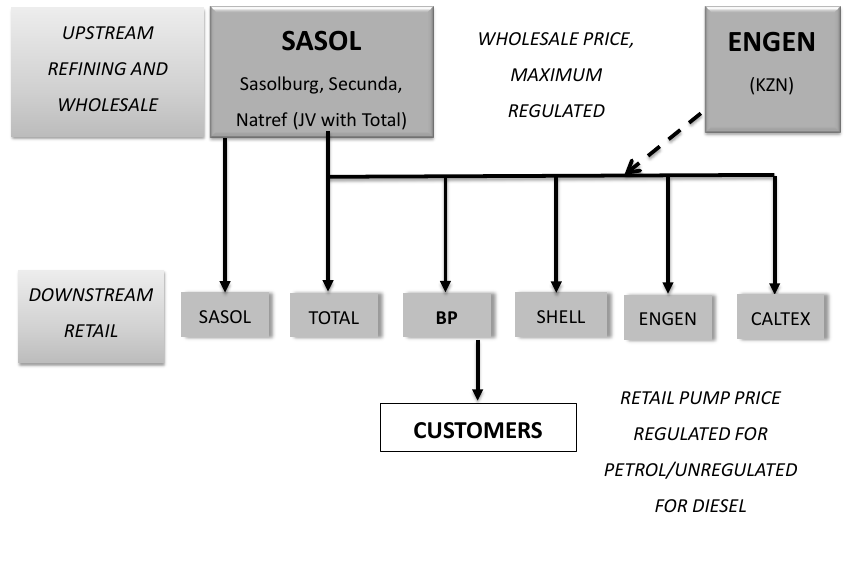
FIGURE 1: Value chain in the inland region Source: Authors’ own